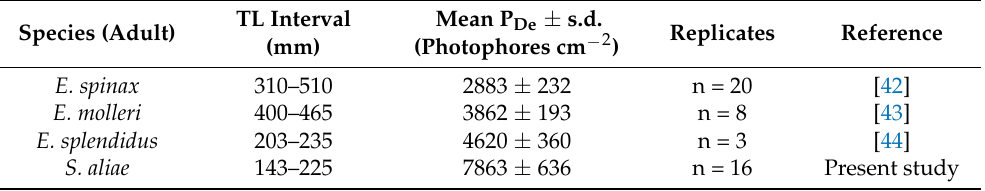
Table 1. TL interval and mean ventral photophore density of adult S. aliae and comparison with three Etmopteridae species.